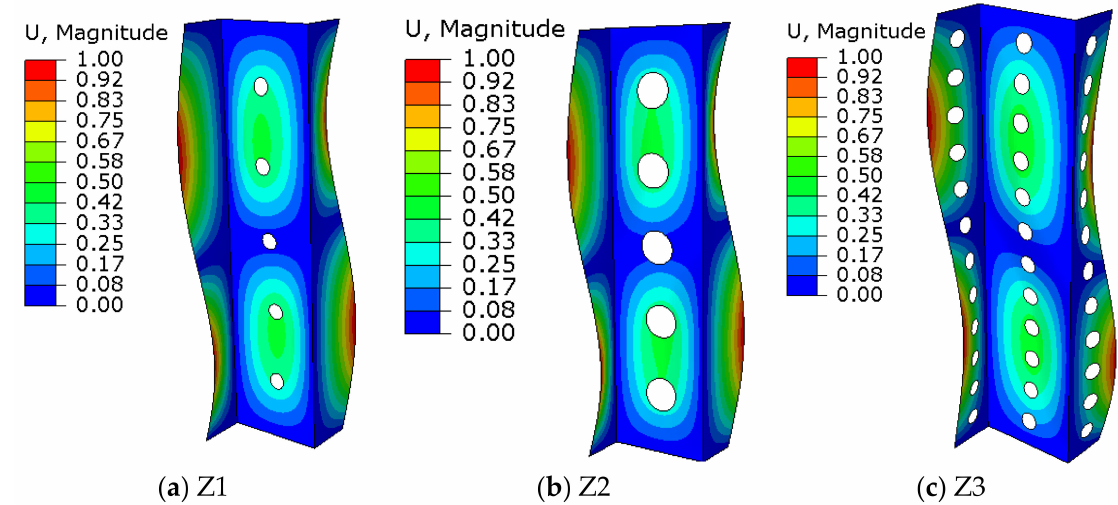
Figure 7. Forms of buckling for exemplary profiles: ( a ) Z1 profile, ( b ) Z2 profile, ( c ) Z3